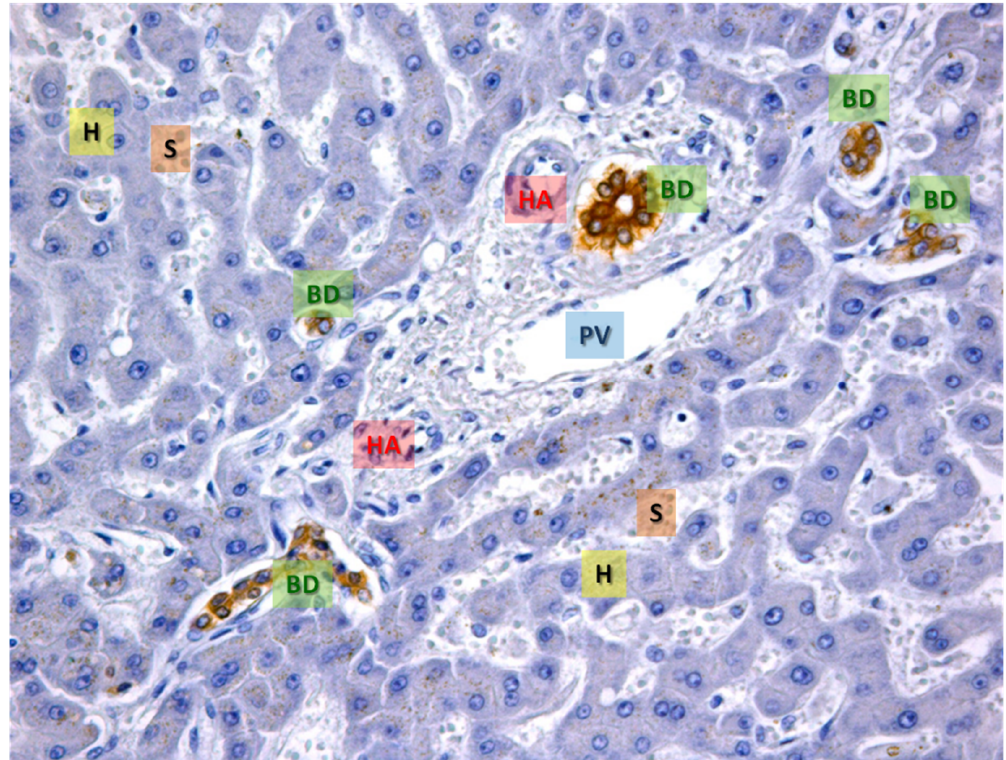
Figure 2. The representative area of normal hepatic tissue. Immunohistochemistry for CK-7, a specific cytokeratin of the biliary epithelium, that is stained in brown (BD). In blue the hepatocytes are evident (H), the white spaces are the sinusoids (S). In the center, a portal space is evident with the typical branches of the portal vein (PV), hepatic artery (HA) and several bile ducts (BD) cut on different planes (transverse or sagittal). OM 20x.